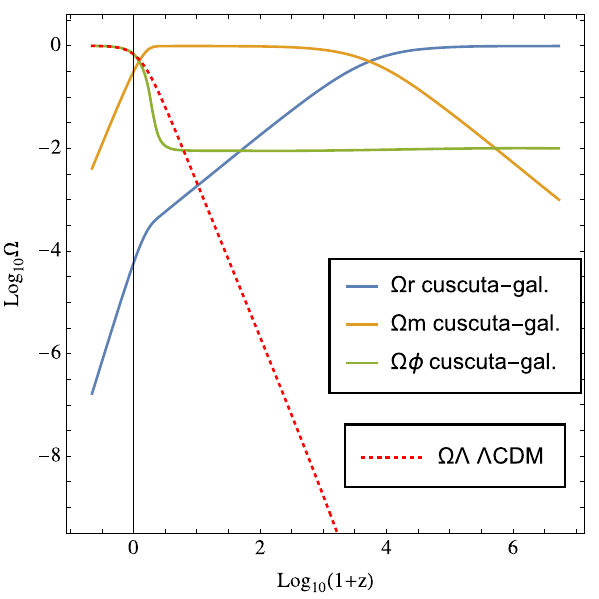
Fig. 4 The evolution of the density parameters in log scale where the initial conditions are the same as the Fig.